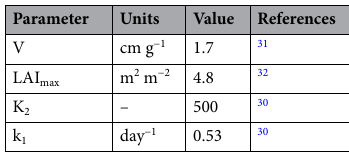
Table 2. The parameters used in the model.